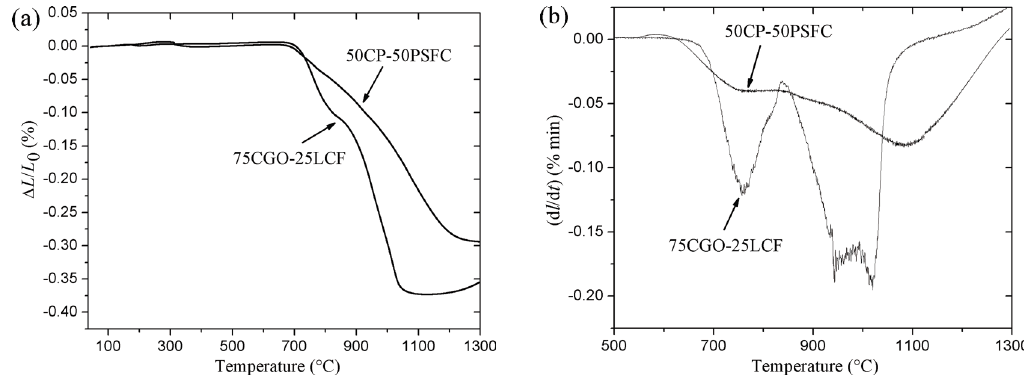
Fig. 5 Dilatometric curves of 75CGCO–25LCF and 50CP–50PSFC samples under air atmosphere up to 1300 ℃ : (a) linear shrinkage and (b) shrinkage